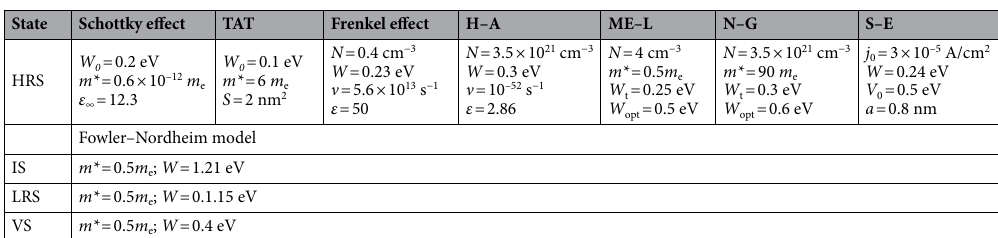
Table 1. Fitting different model parameters for simulating the I – V characteristics of the SiN x -based